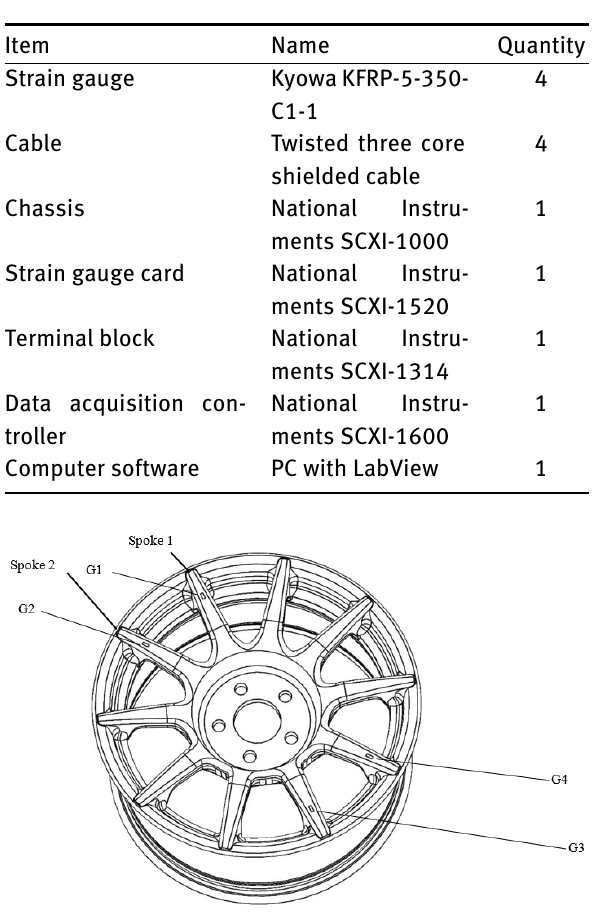
Table 1: Instrumentation used on the experimental prototype